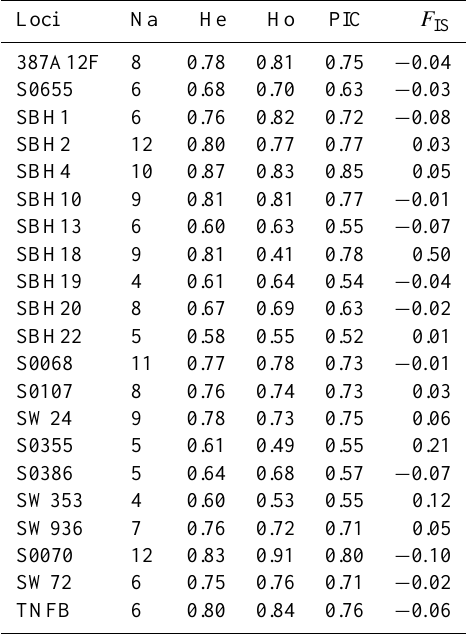
Table 3. Microsatellite diversity in breeding PC boars. Loci Na He Ho PIC F IS